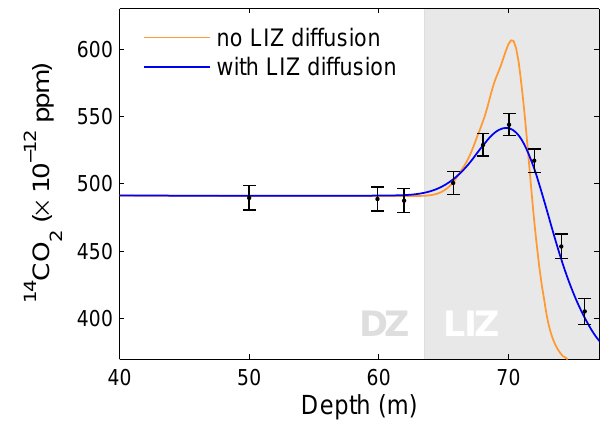
Fig. 6. Modeled 14 CO 2 profiles both with, and without diffusivity in the LIZ. Calculations done with the CIC firn air